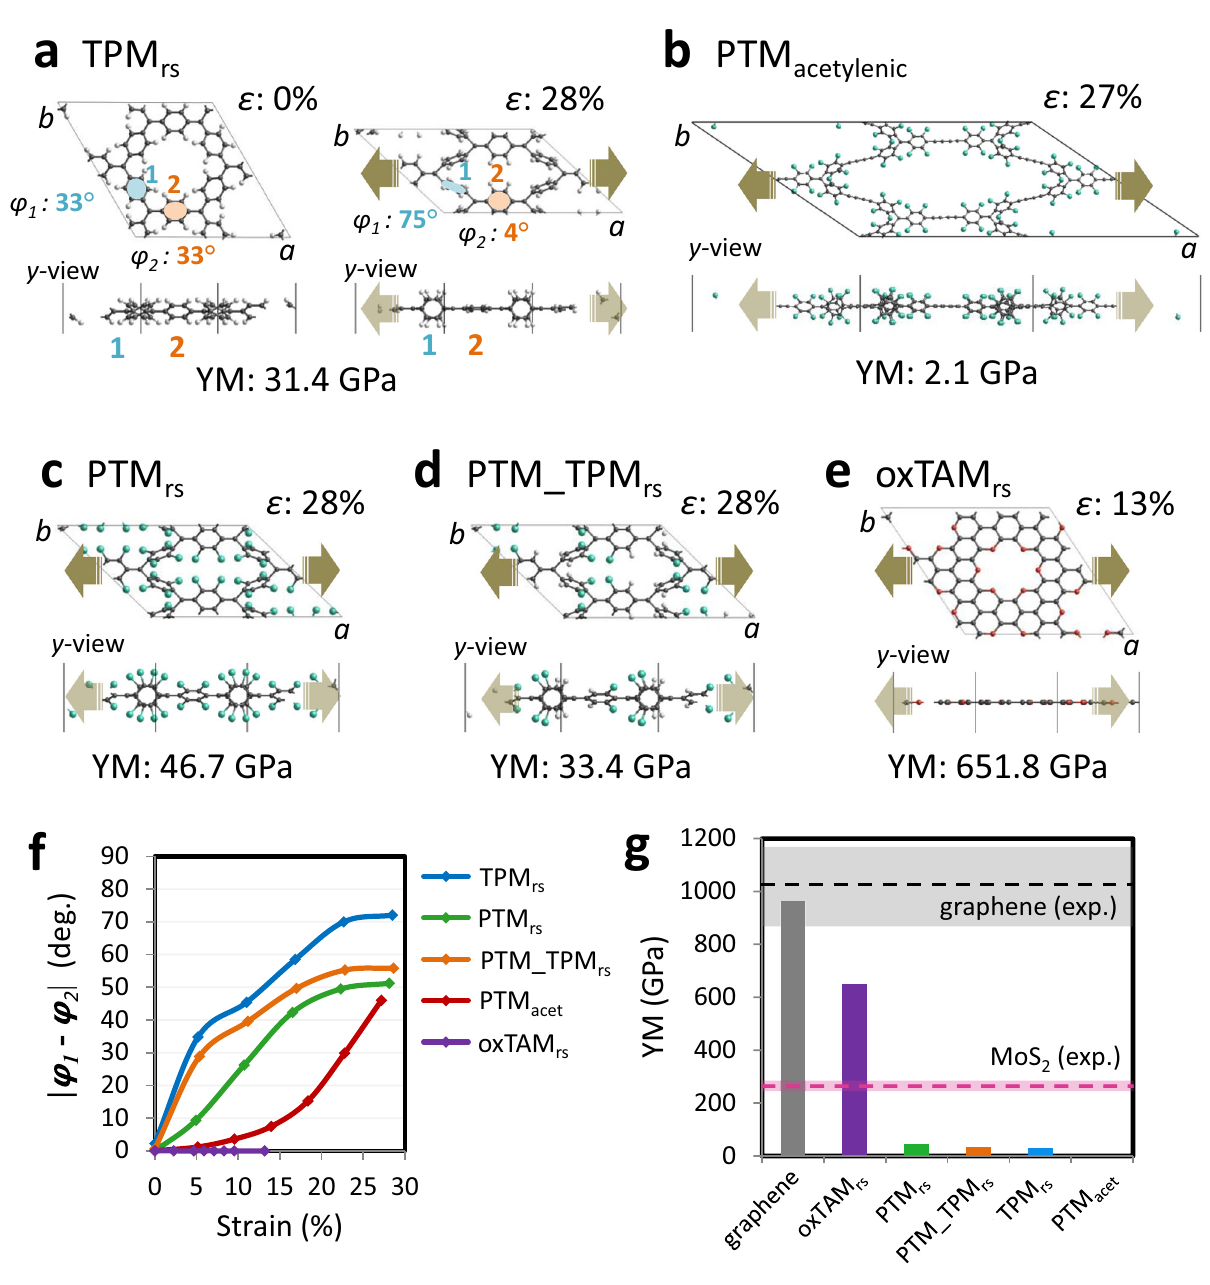
Fig. 3 Structural response to strain. a – e Crystal structures of the most stretched conformations for each of the studied 2D-CORFs indicating the associated strain ( ε ) and in-plane Young ’ s modulus (YM). Atom colour key: C — dark grey, H — light grey, Cl — green, O — red. f Dihedral angle difference between the out-of-plane ( φ 1 ) and in-plane ( φ 2 ) twisted aryl rings versus uniaxial strain. g Calculated in-plane YM values for all 2D-CORFs and graphene (vertical bars) compared to experimental YM values of graphene 53 and single layer MoS 2 54 (horizontal dashed lines), where the associated range within which experimental values have been reported are indicated with coloured panels (see Table S1 in the SI for